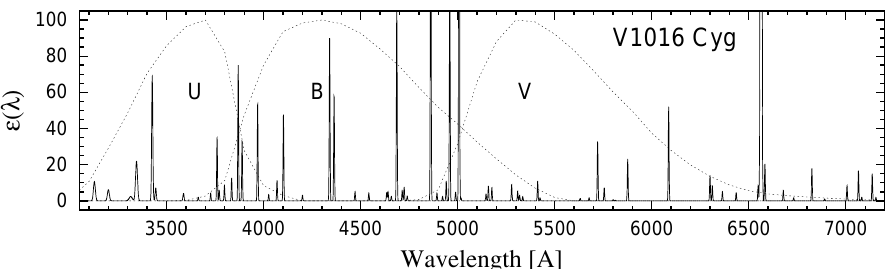
Fig. 2. Function (cid:3) ( λ ) for the symbiotic nova V1016 Cyg, which rep- resents its emission-line spectrum in units of the continuum. Dotted lines show normalized response functions of the U, B, V filters.